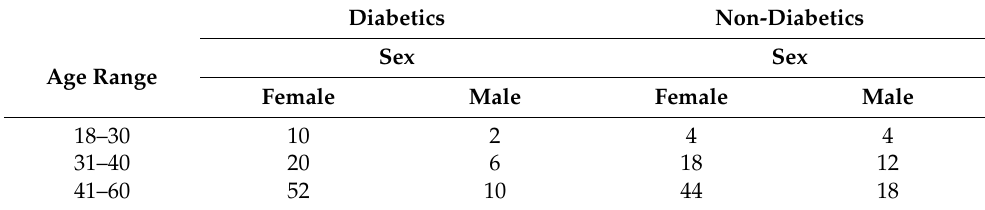
Table 1. Age and gender of study participants.